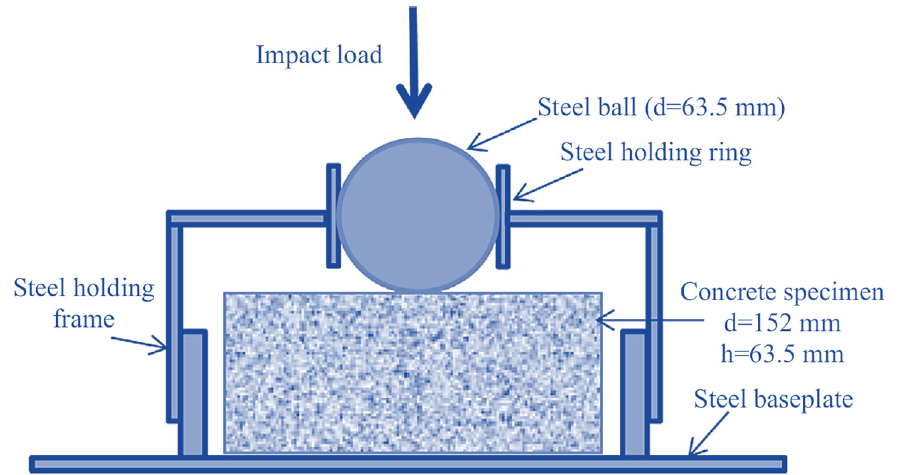
Figure 2. The ACI drop-weight impact test.